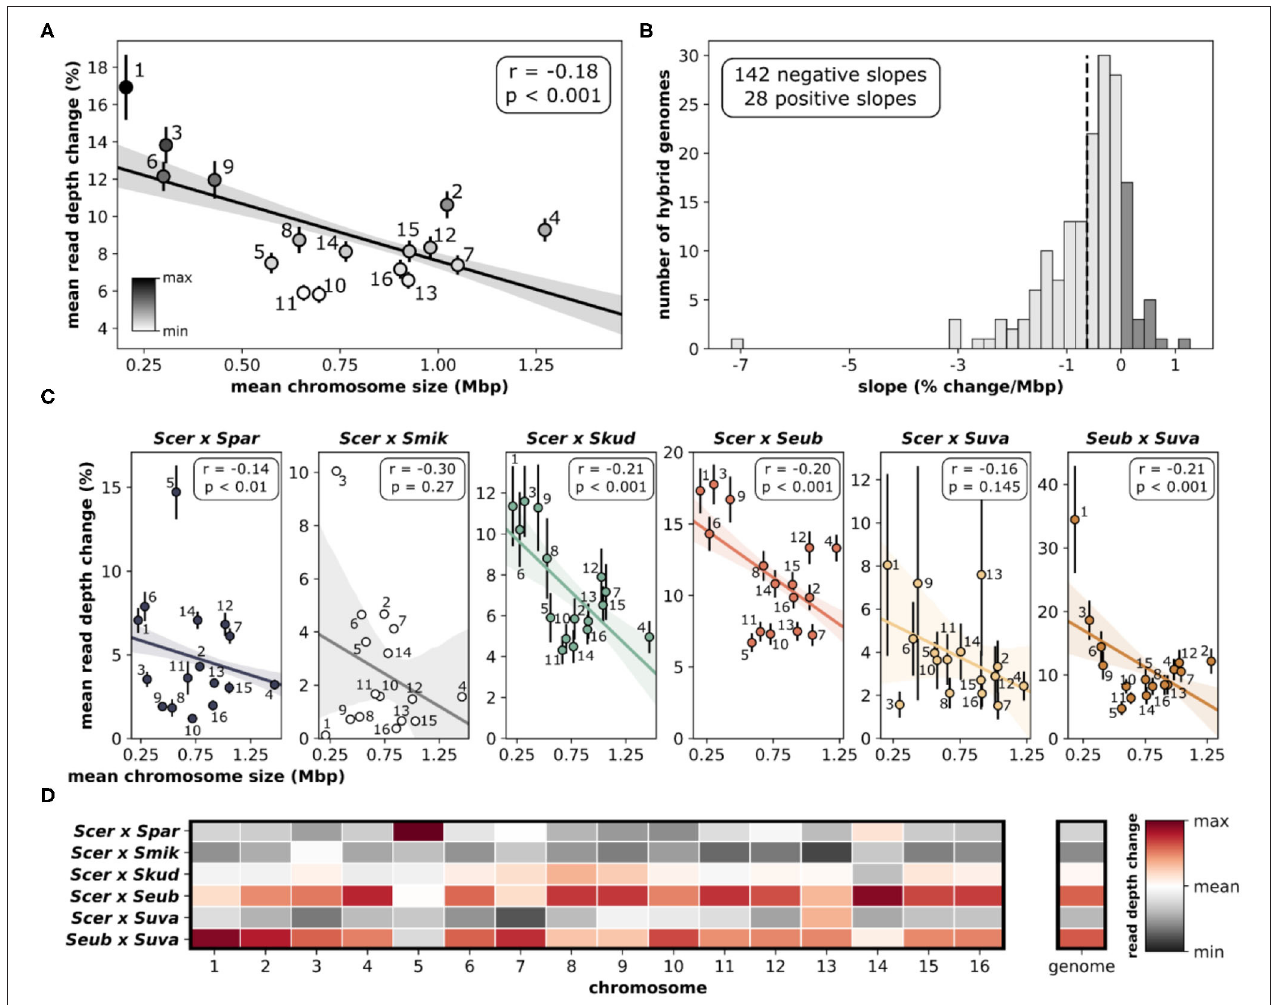
FIGURE 7 | Relationship between chromosome size and aneuploidy. (A) Linear correlation between chromosome size and delta mean read depth. Delta mean read depth is calculated as the absolute difference between the total chromosomal read depth (species 1 + species 2) and the total genome read depth. Means and standard error for each independent chromosome are shown and labeled. The linear regression line with 95% confidence intervals is shown. (B) The distribution of slopes generated from linear regressions for each hybrid genome ( n = 170). All of the linear regressions for each hybrid cross are depicted in Supplementary Figure 7 . Dashed vertical line indicates the mean. (C) Linear correlations between chromosome size and delta mean read depth for each hybrid cross. (D) Mean read depth change for chromosomes compared across hybrid crosses. Each chromosome (column) has been normalized for comparisons. Red indicates the maximum read depth change for that chromosome, white indicates the overall mean and dark gray indicates the minimum. Mean read depth change for the whole genome is also normalized and